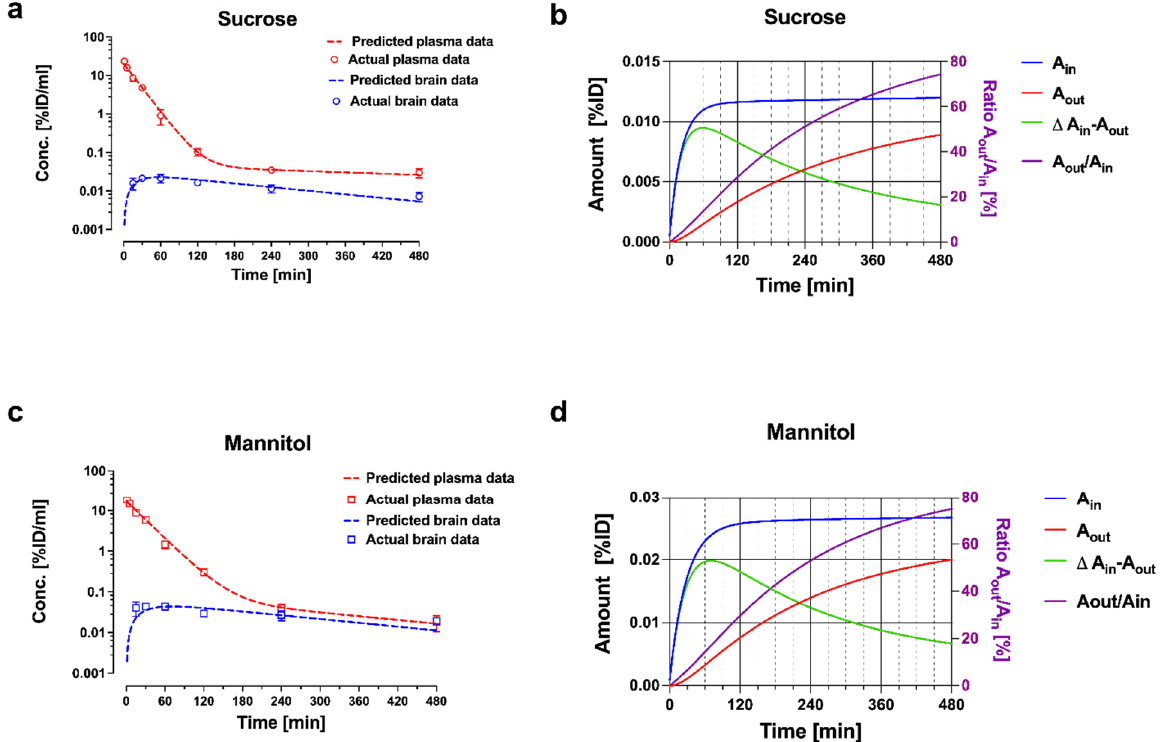
Figure 5. Plasma and brain pharmacokinetic data with model fitting for ( a ) sucrose and ( c ) mannitol. Plasma and brain concentrations are expressed in percent of injected dose (%ID/mL). Panels ( b ) and ( d ) depict cumulative amounts of sucrose and mannitol entering (A in ) and leaving (A out ) the brain compartment, and the ratio of A out /A in over time. Reprinted with permission from Reference [19]. Copyright 2022, Springer